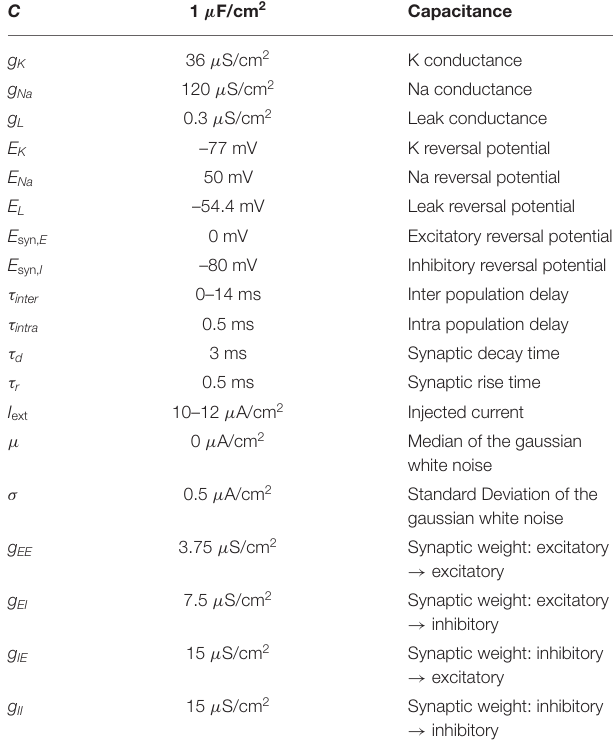
TABLE 1 | Parameters of the